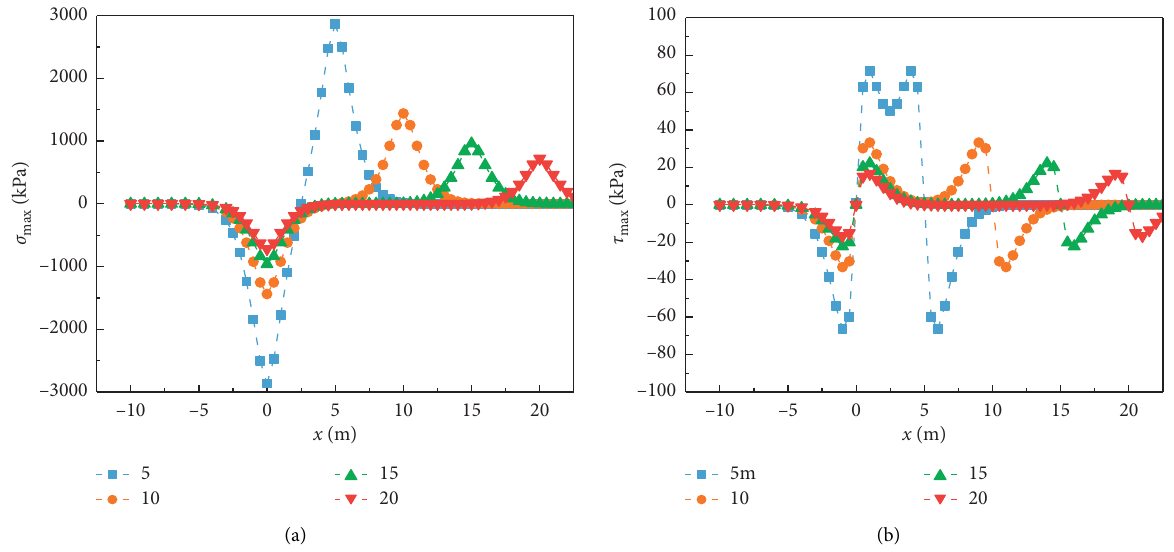
Figure 8: Distribution law of maximum normal stress (a) and maximum shear stress (b) of the cross-section at different transition section lengths.